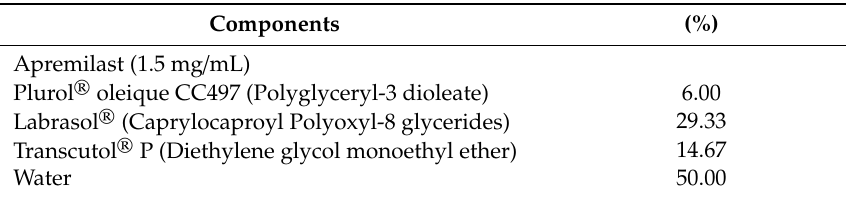
Figure 3. Pseudo-ternary phase diagrams using different ratios of surfactant/co-surfactants (S mix ) at 25°C.